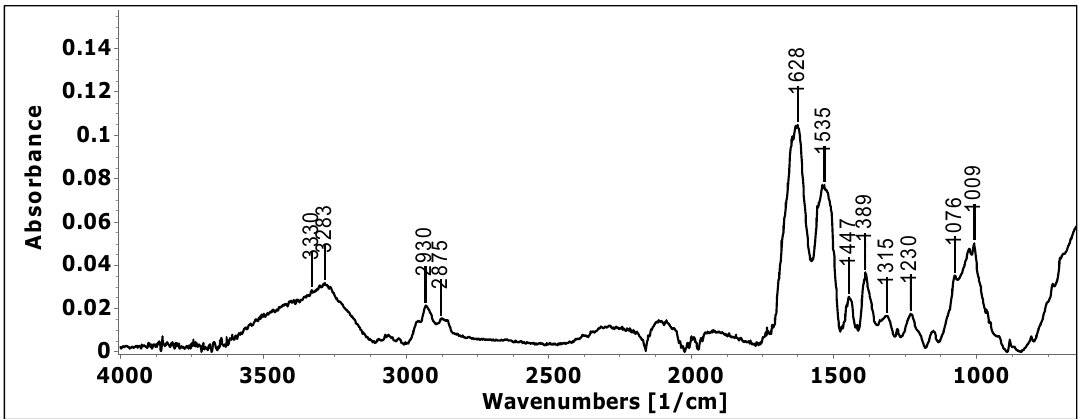
Figure 1. FT-IR spectra of the final product (NN sample). Peaks specific for phenolic compounds have also been identified. So, the bands 1233 cm − 1 are a function of the protonation of phenolic acids and are assigned to the stretching vibration of C-OH in the carboxylic group [25]. The peak at 1390 cm − 1 is characteristic of COO stretching [26]. Aromatic C-C extending to ~1520 (peak overlapping with the specific Amide II peak) and ~1447 cm − 1 is related to phenolic compounds [27]. The band at ≈ 2900 cm − 1 corresponds to the C-H stretching vibration that reflects the organic content in general [28]. Several peaks located in the region of 1070–1150 cm − 1 are mainly attributed to stretching vibrations of C-O and C-C [29]. The absorptions at 1230 cm − 1 have been assigned to phenol hydroxyl group [30]. The stretching of ether linkage, C-O-C, is indicated by the absorption at 1009 cm − 1 [31]. The high protein content (80.97%) of the final formulation is a result of using high proportions of hydrolyzed collagen (90.30%) and egg white (82.05%), two important sources